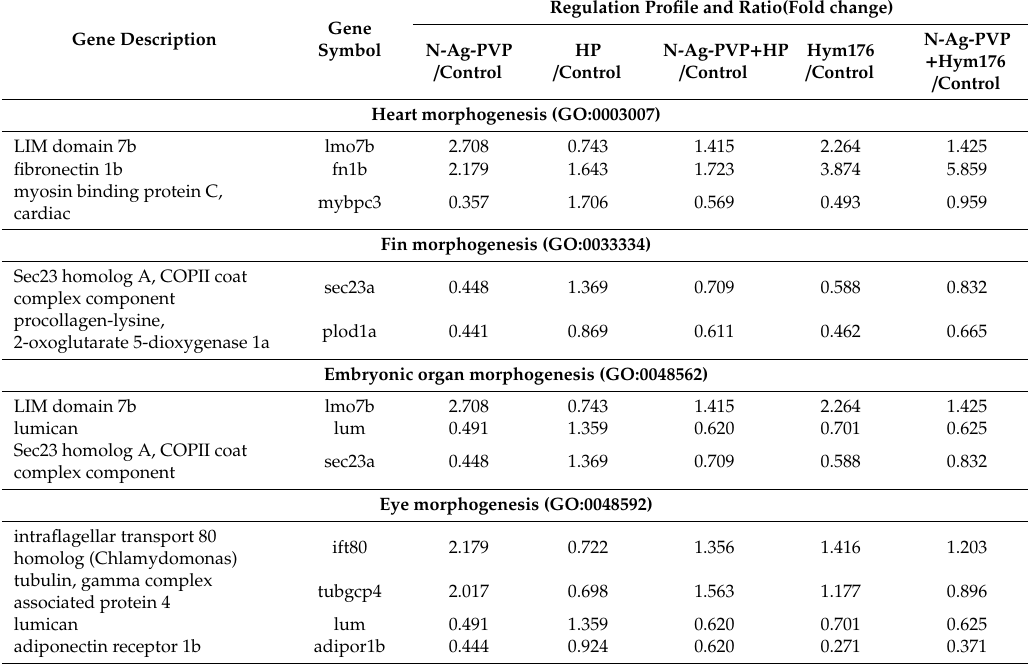
Table 4. Genes showing toxicity reduction e ff ects classified according to GO of